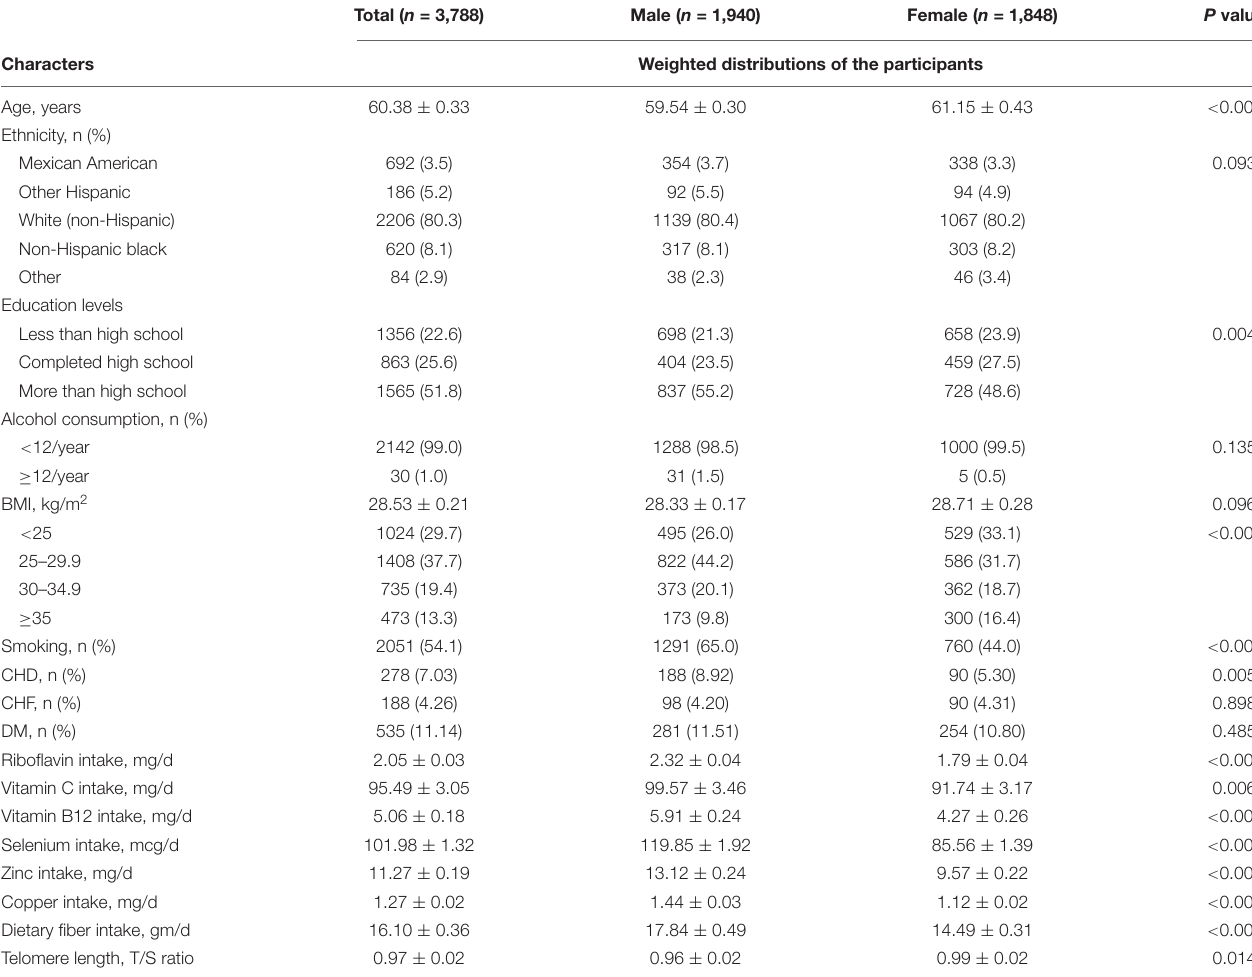
TABLE 1 | Sample size and weighted characteristics of NHANES